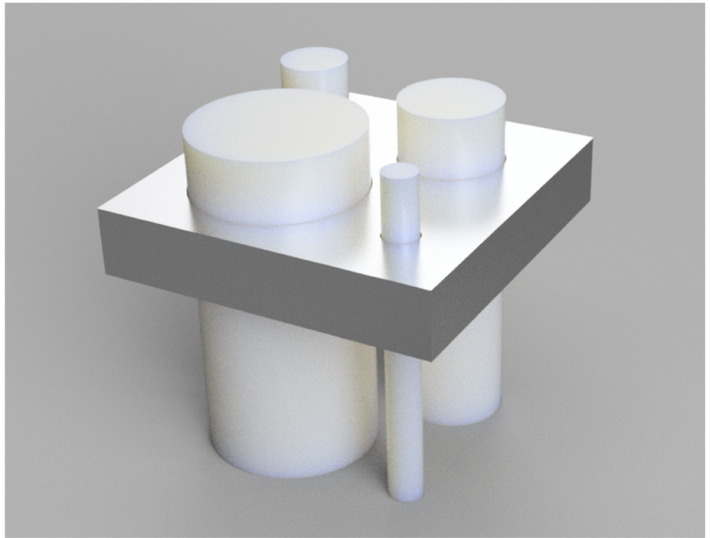
Figure 1. A feeler gauge was designed for symmetry preservation checks. Starting with 5 mm, the test specimens had to fit through the gauge before and after the printing process with a radius tolerance of 0.1 mm.